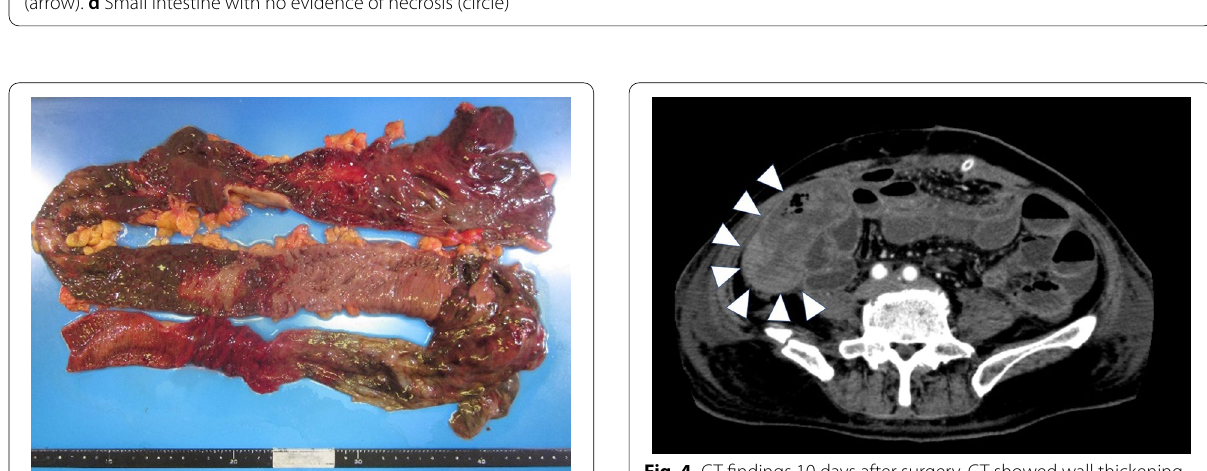
Fig. 4 CT findings 10 days after surgery. CT showed wall thickening and a decrease in contrast effect in some small intestines